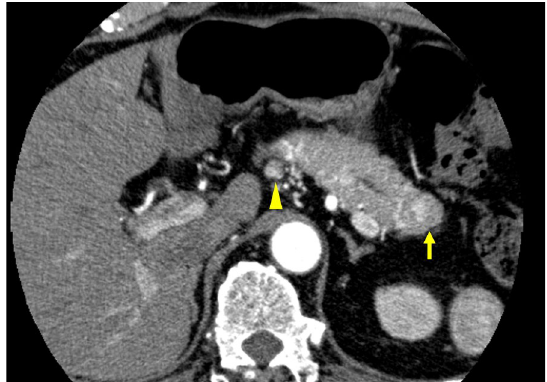
Fig. 1 Contrast-enhanced computed tomography images before the operation. Hypervascular lesions were identified in the pancreatic parenchyma (yellow arrow), and a regional lymph node was swollen (yellow